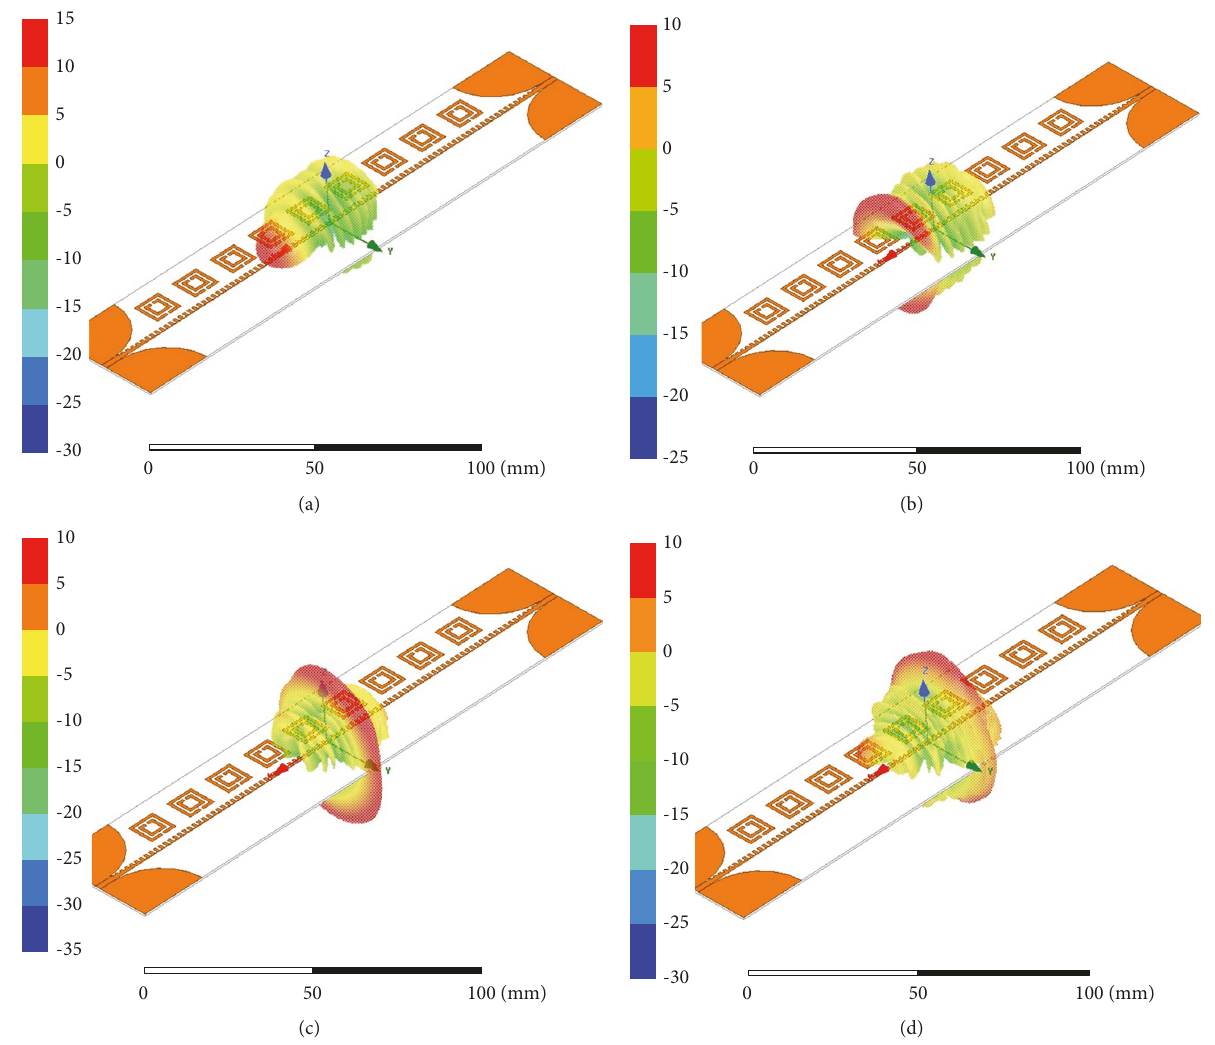
Figure 7: Antenna pattern in different dispersion regions. (a) Slow wave. (b) Left-handed fast wave. (c) Broadside. (d) Right-handed fast